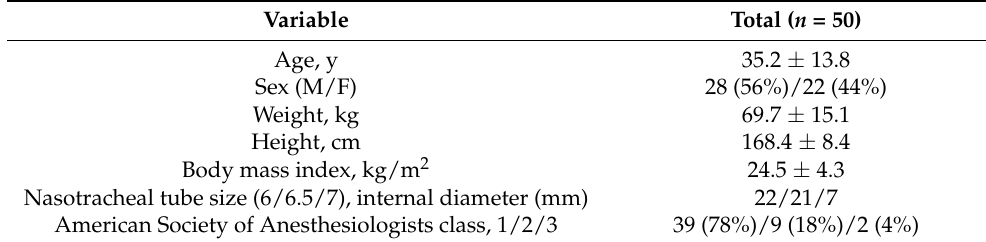
Table 1. Patients’ characteristics.